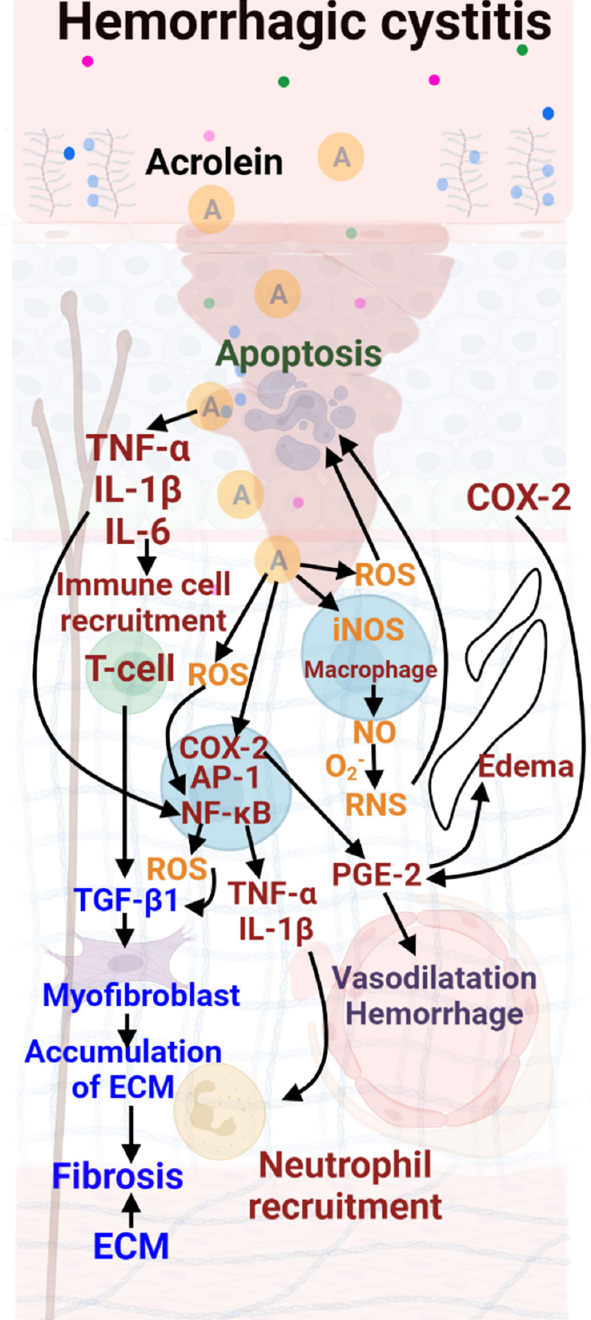
Figure 3. Molecular mechanisms involved in Hemorrhagic Cystitis (HC). Supplementary lesions are described as edema due to COX-2, which induces PGE-2. PGE-2 also induces vascular damage. A neutrophil recruitment is observed. Color code: red: inflammation; green: urothelial damage; blue: fibrosis; purple: vascular damage; orange: hypoxia. Chronic Radiation Cystitis